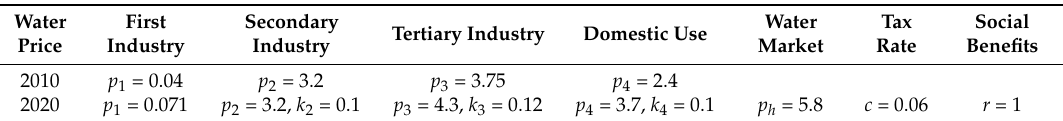
Table 7. Water prices in 2010 and 2020 (Unit: yuan/m 3